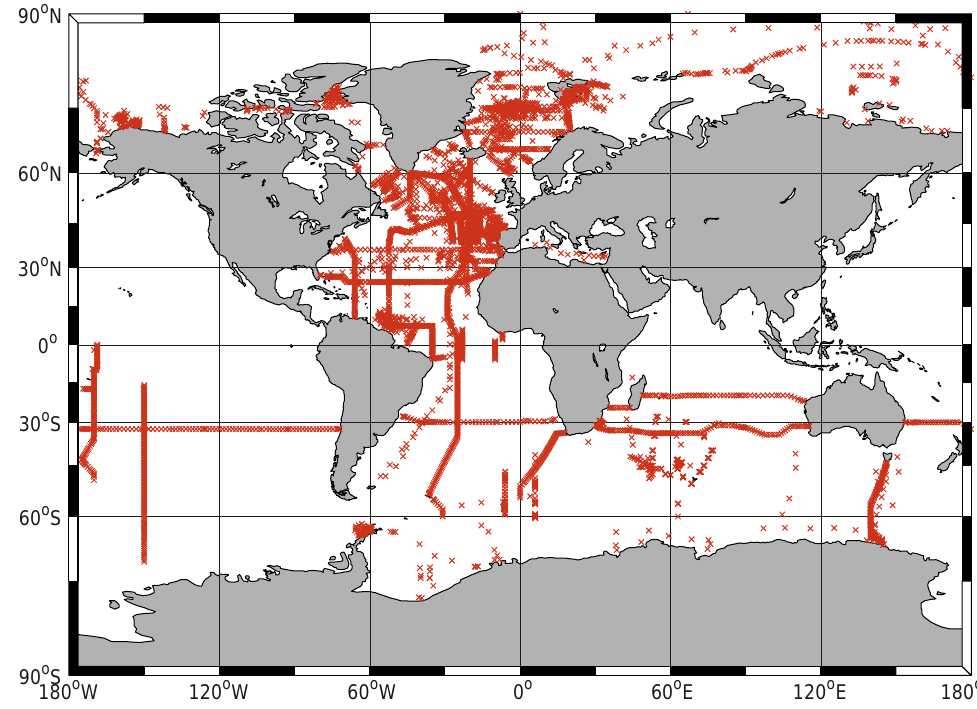
Figure 1. Map of stations with pH data in the full CARINA dataset (ATL, AMS and SO merged).